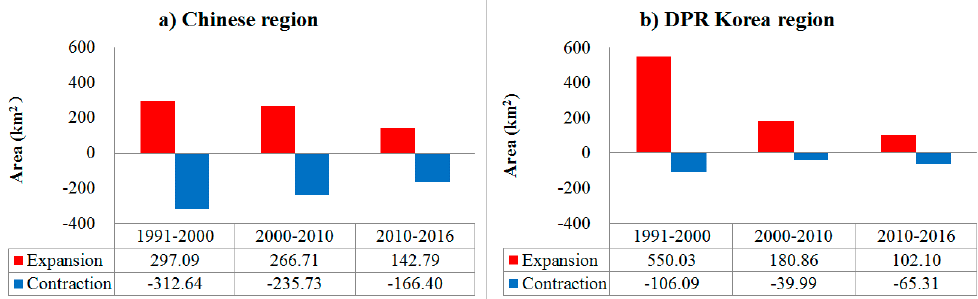
Figure 7. Proportions ( a , b ) of farmland changes across different regions over the three time periods evaluated in this study.